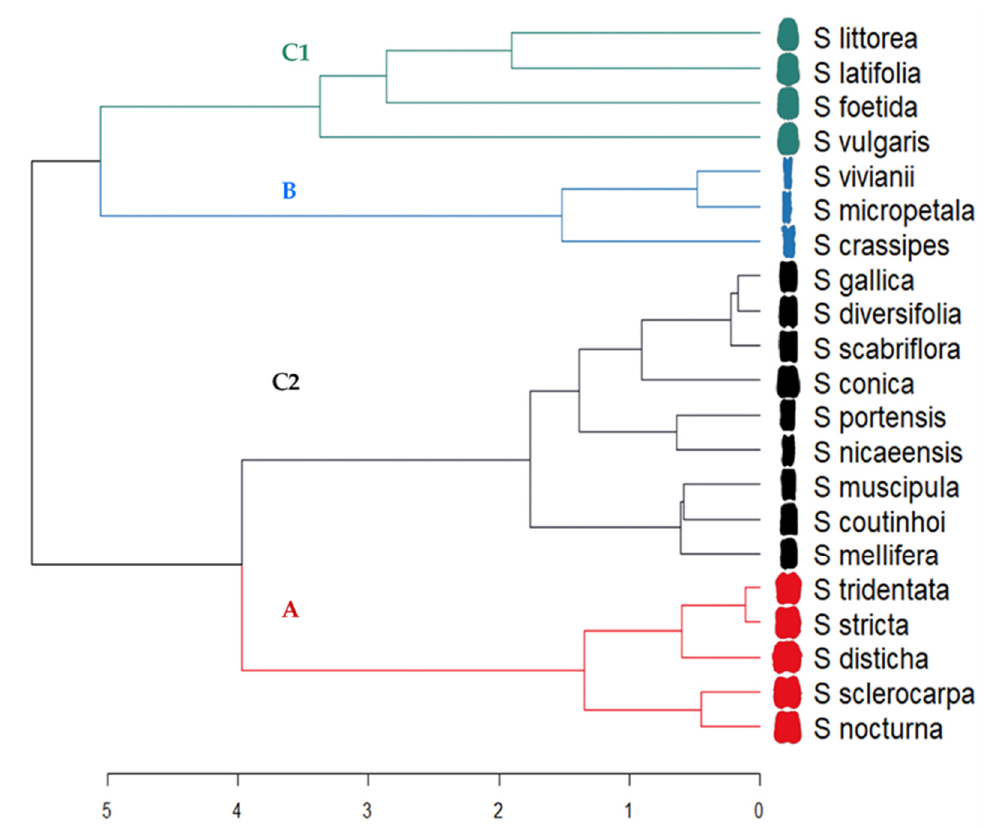
Figure 4. Dendrogram based on hierarchical clustering from morphological data including convexity as a binary factor (presence/absence). Four clusters are identified according to the color of branches. The average silhouettes obtained for the dorsal views of the different Silene species are represented based on the cluster/color.